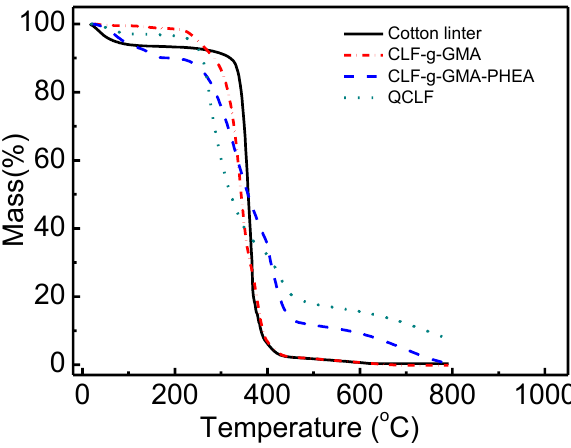
Figure 5. TG analysis for cotton-linter, CLF-g-GMA, CLF-g-GMA-PEHA and QCLF.